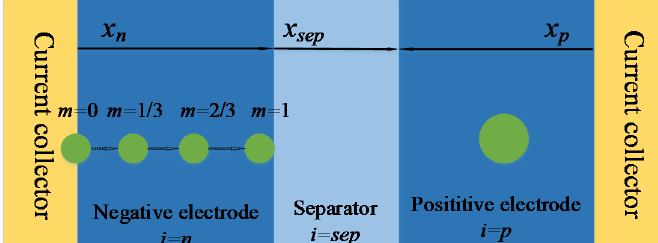
Figure 2. Physical structure of simplified multi-particle model.